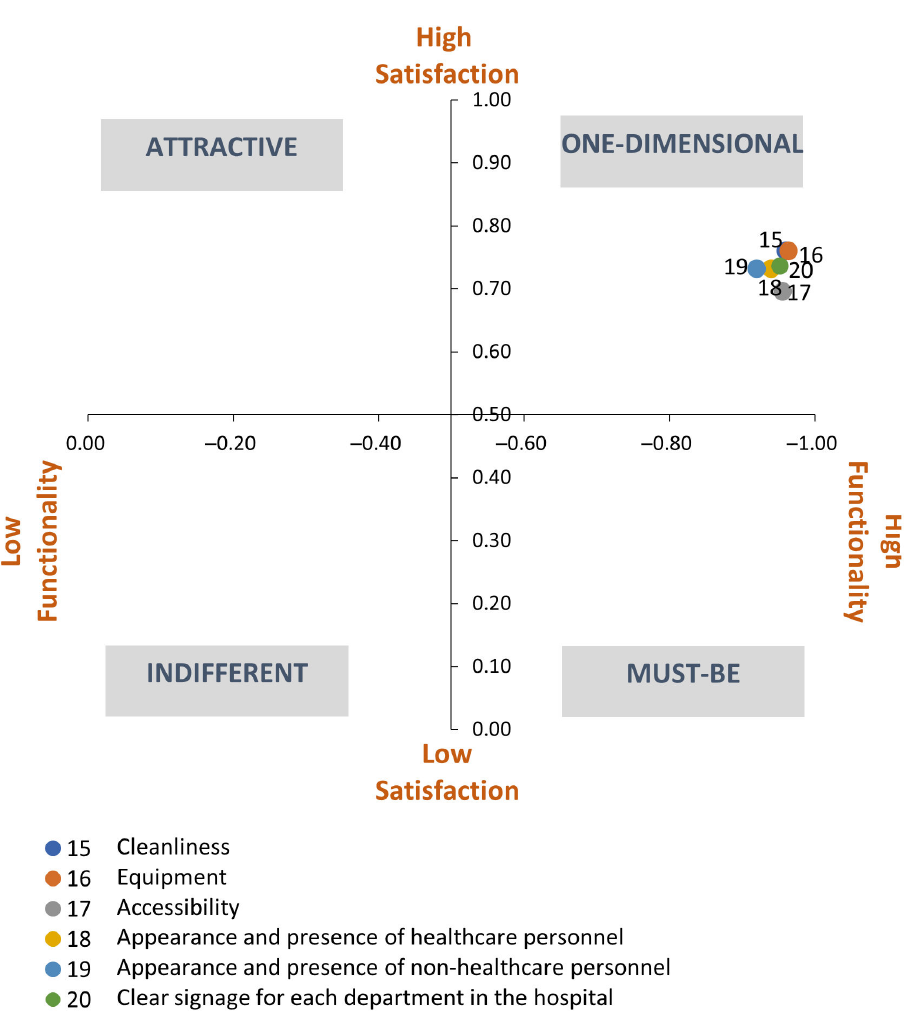
Figure 4. Classification of the attributes of the facilities, equipment, and tangibles